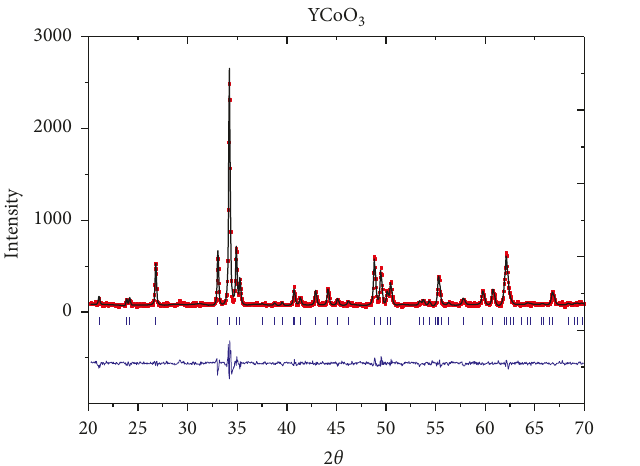
Figure 2: X-ray diffraction pattern and its matching refinement plot of YBaCo 2 O 6 δ : observed X-ray diffraction intensity (points) and calculated curve (line). The bottom curve is the difference of − patterns, y obs y cal , and the small bars indicate the angular posi- tions of the allowed Bragg reflections. −